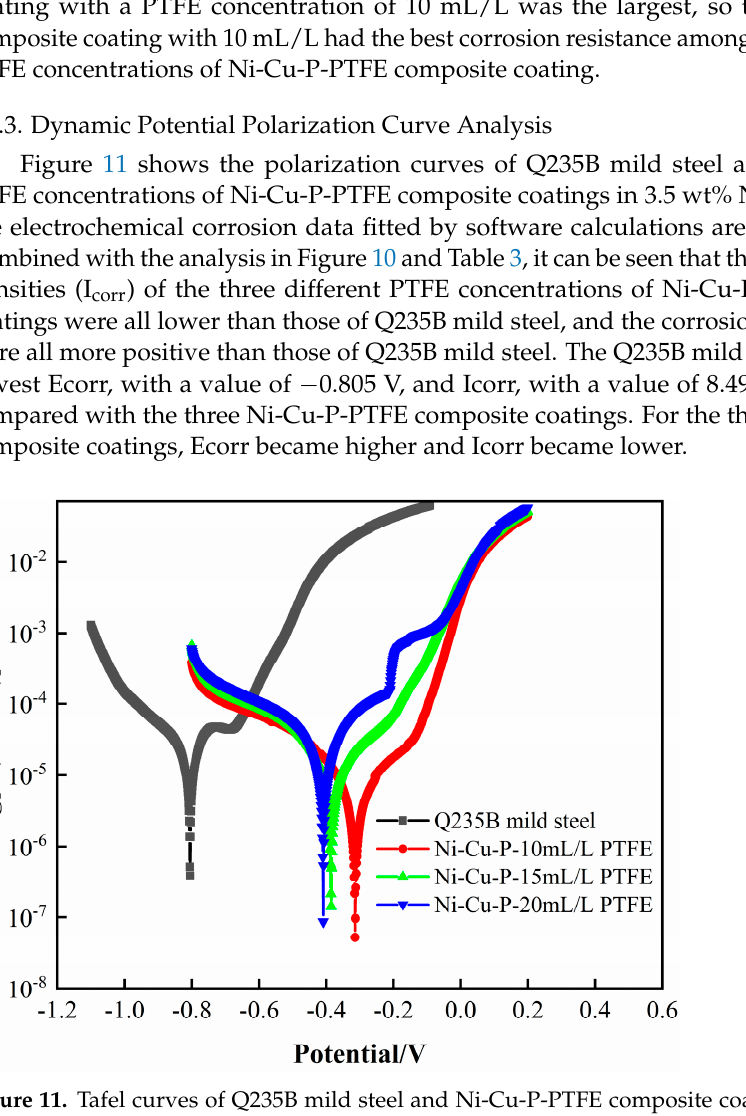
Figure 11. Tafel curves of Q235B mild steel and Ni-Cu-P-PTFE composite coatings with different PTFE concentrations in 3.5 wt% NaCl PTFE concentrations in 3.5 wt% NaCl solution. Table 4. Electrochemical parameters of different samples in 3.5 wt% NaCl solution.